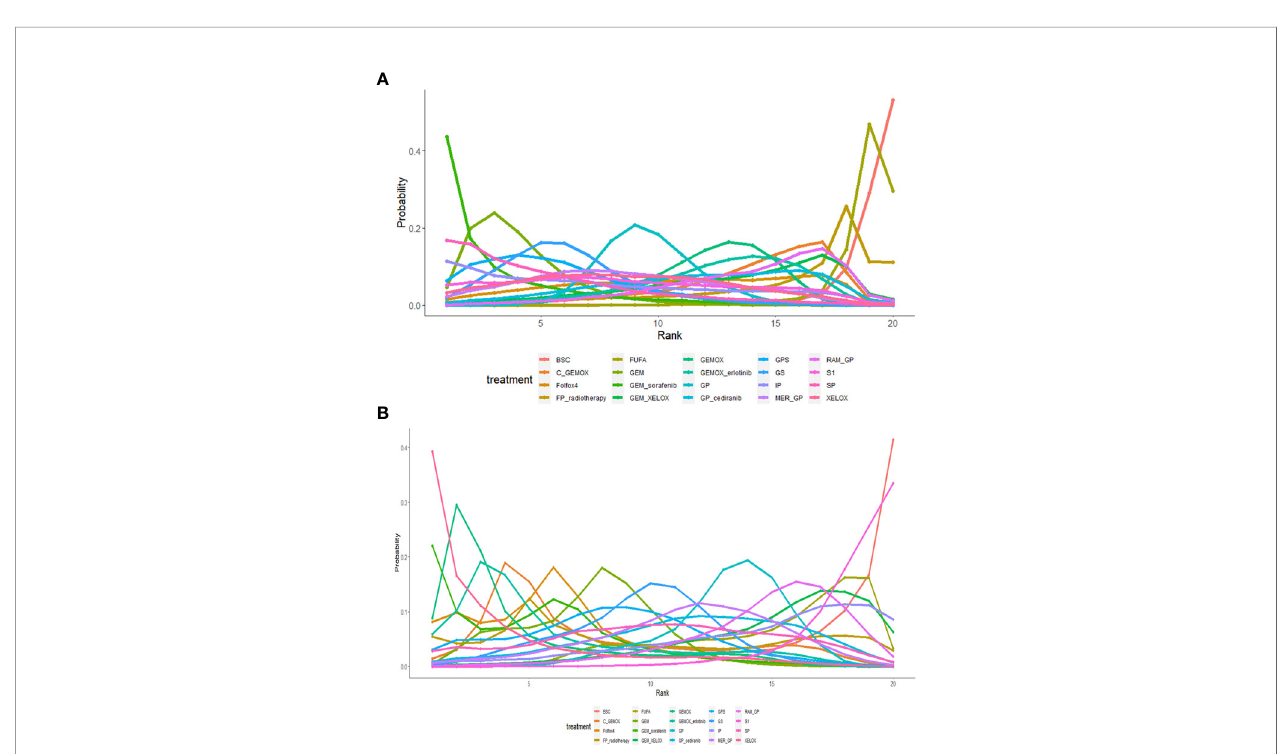
FIGURE 3 | Bayesian network meta-analysis (NMA) results of overall survival (OS) and progression-free survival (PFS) of key outcome indicators for different protocols.